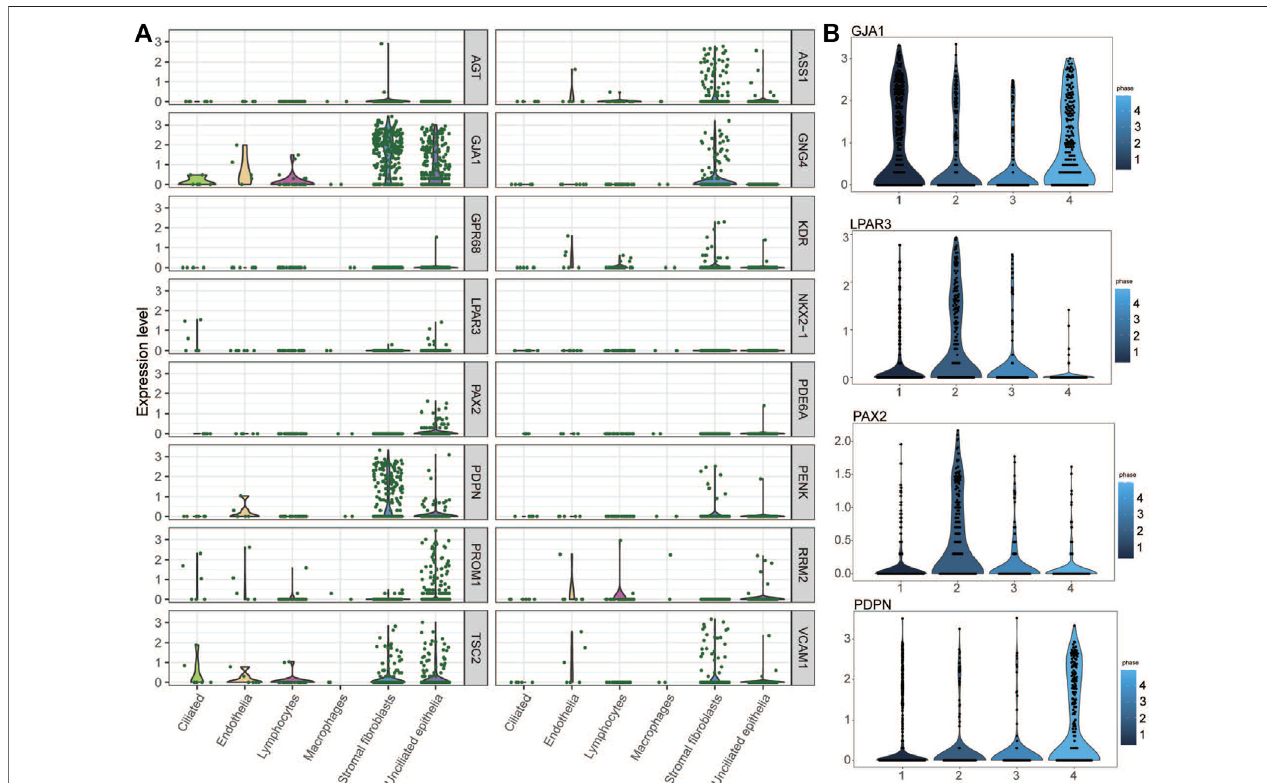
FIGURE 8 | Key genes in the single-cell RNA-seq transcriptome pro fi le of the normal endometrium. (A) Expression of key genes in the mid- and late-secretary menstrual phase. (B) PDPN, GJA1, LPAR3, and PAX2 expression variation during four menstrual phases.